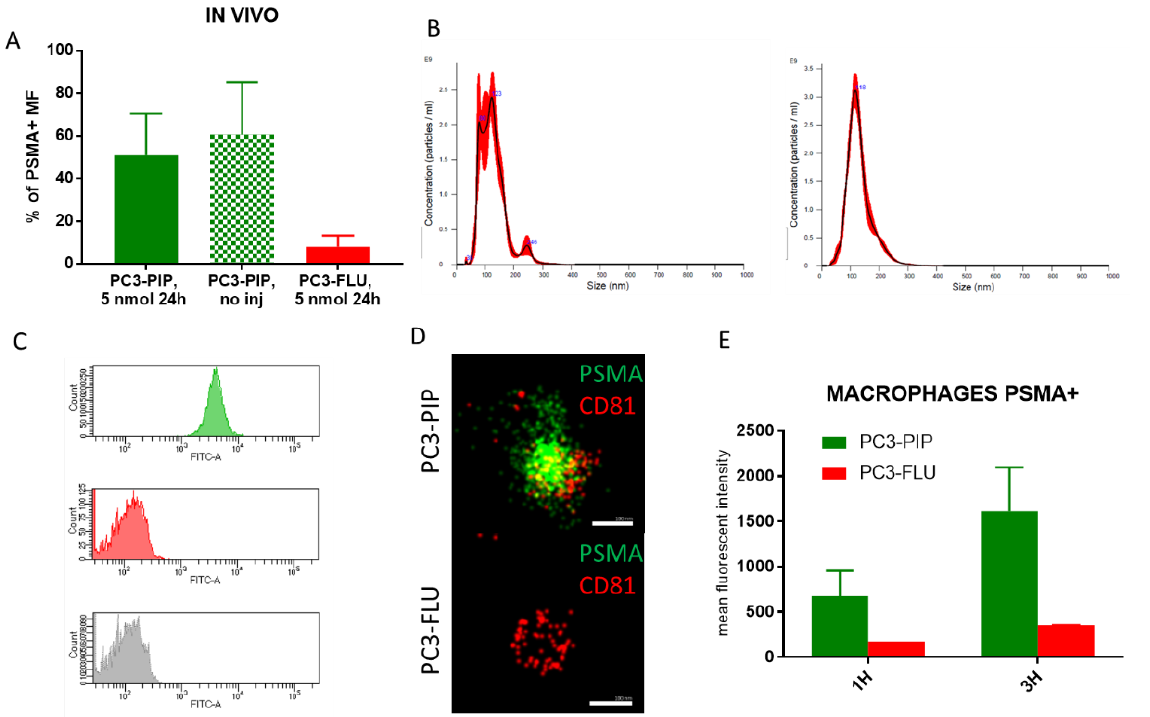
Figure 6. Extracellular Vesicles and macrophages interaction. ( A ) Flow cytometry data of % of PSMA positive macrophages in PC3-PIP and PC3-FLU tumour tissue; ( B ) representative graph of nanoparticles tracking analysis of EVs from PC3-PIP (left panel) and PC3-FLU (right panel) cells; ( C ) Representative flow cytometry data showing the expression of PSMA on the surface of PC3-PIP-EVs (green); PC3-FLU did not express PSMA (red). ( D ) Representative super resolution microscopy images of EVs from PC3-PIP (upper panel) and PC3-FLU (lower panel) showing the expression of PSMA (green) and CD81 (red). AlexaFluor488 (PSMA) 495 – 519 nm; AlexaFluor 647 (CD81) 650 – 655 nm. The scale bares are below each EV image (100 nm); ( E ) Flow cytometry data of PSMA in macrophages cell culture incubated with EVs from PC3-PIP or from PC3-FLU for 1 h and 3 h. As a proof of concept, a fluorescent guided surgery procedure, performed 24 h after the administration of 5